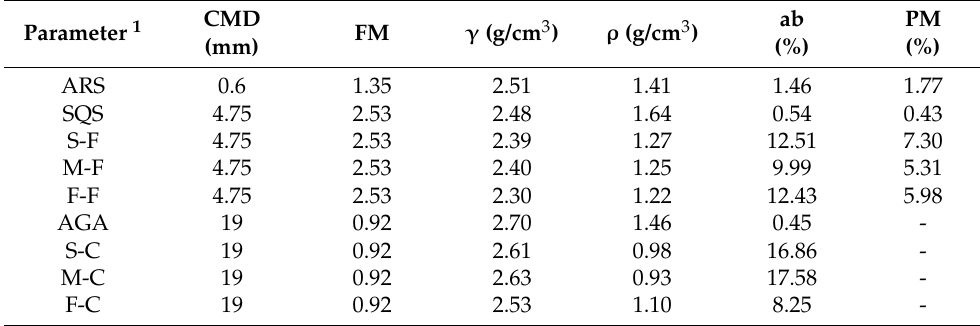
Table 3. Characterization of the recycled aggregates. Parameter